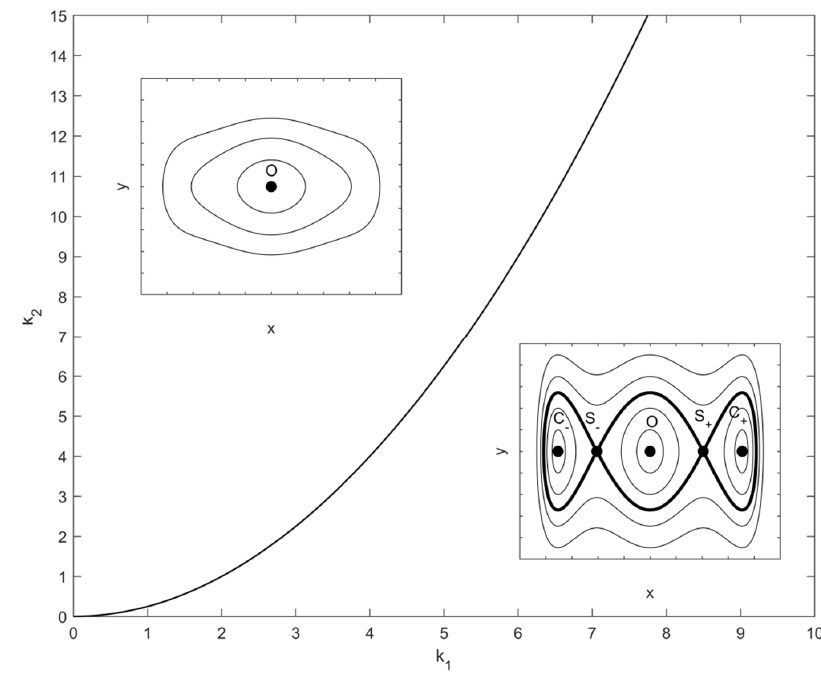
Figure 2. Orbits of the unperturbed system (6) under different values of k 1 and k 2 .